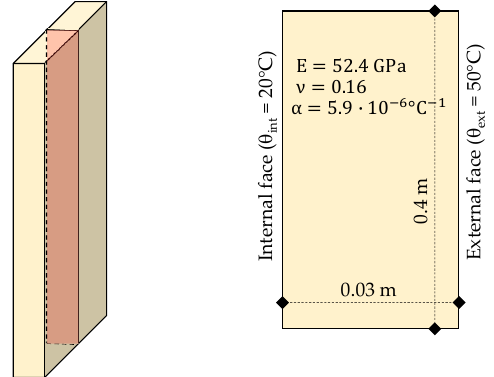
Figure 3. Model used in validation test.